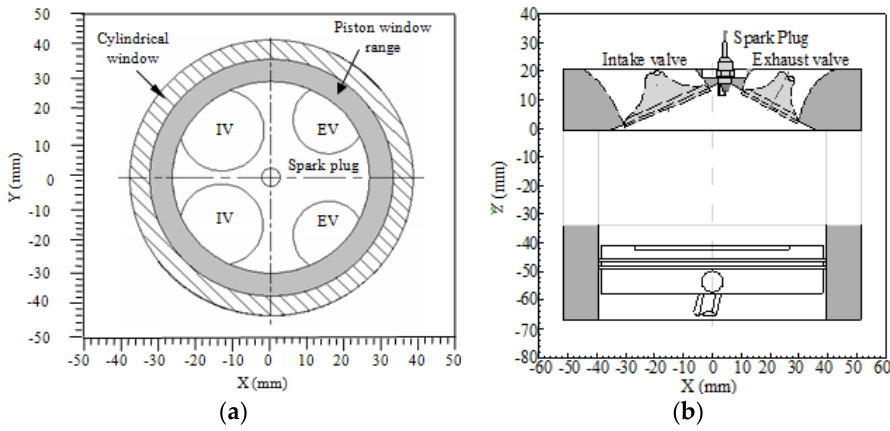
Figure 4. Optical measurement area for investigating ( a ) swirl flow and ( b ) tumble flow.